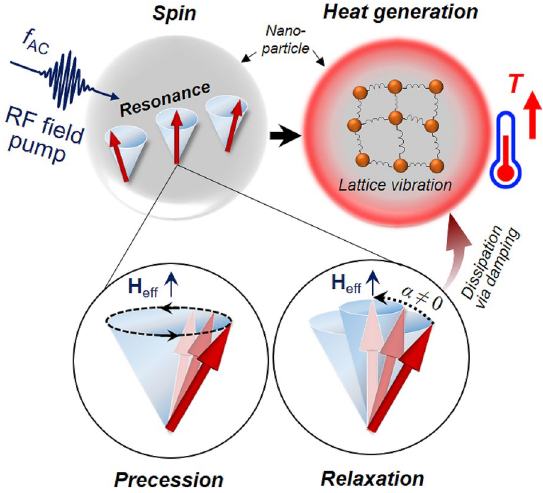
Figure 1. Resonant spin-excitation and relaxation dynamics for dissipative local heating. RF magnetic fields were applied to excite magnetic nanoparticles under an external DC magnetic field. When the RF field frequency was tuned to an intrinsic resonant frequency of the precession of individual magnetic moments (indicated by red arrows), the precession on a specific angle occurred around the internal effective field (see blue cones). Simultaneously, the precession of the magnetic moments started to lose a certain amount of absorbed magnetic energy owing to intrinsic damping, resulting in the reorientation of magnetizations in the DC field direction. The energy due to magnetic loss was dissipated in the form of lattice vibrations through the various spin–lattice interactions, thereby increasing the temperature of the magnetic